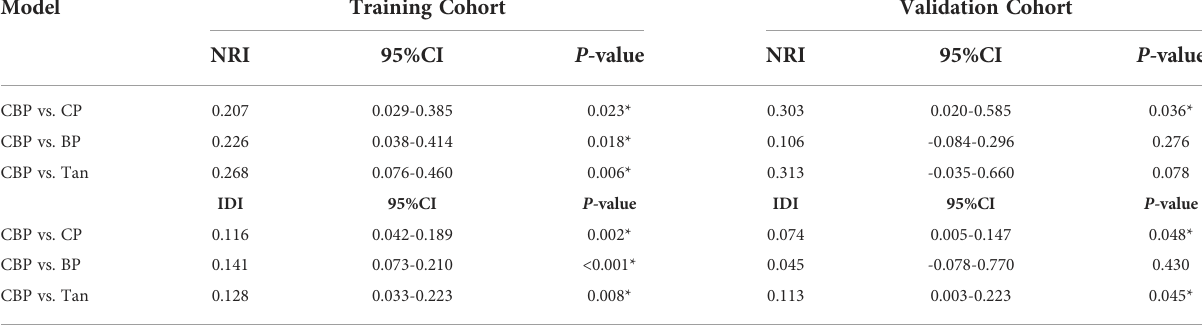
TABLE 4 Model performance in the training and validation